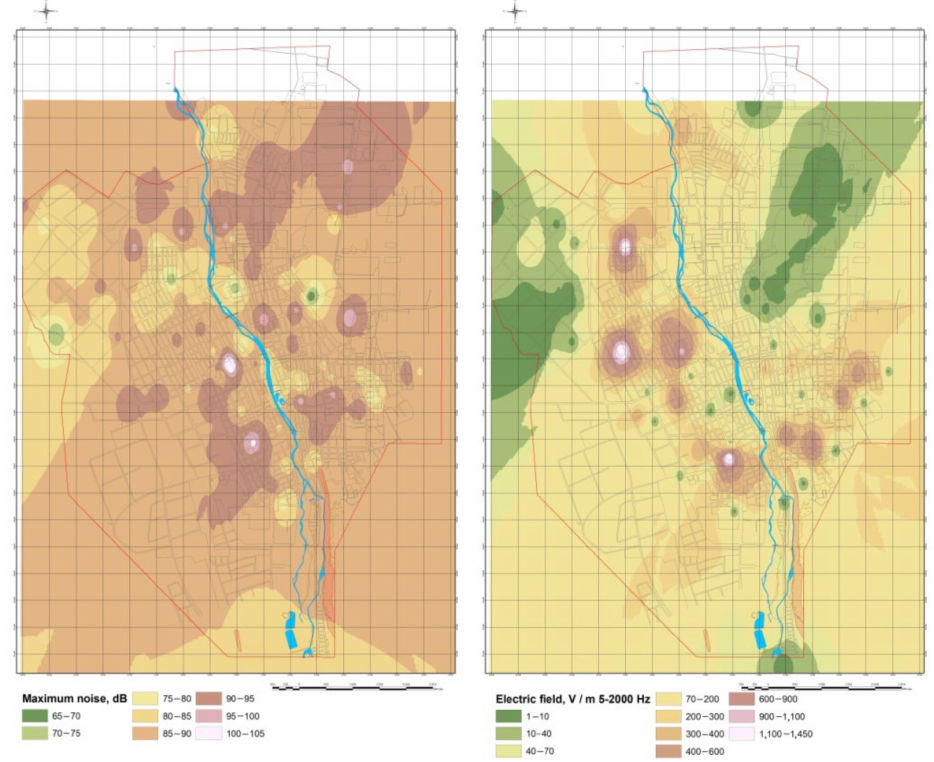
Figure 7. Maps of noise pollution and distribution of the electric field level (V/m) registered in the territory of